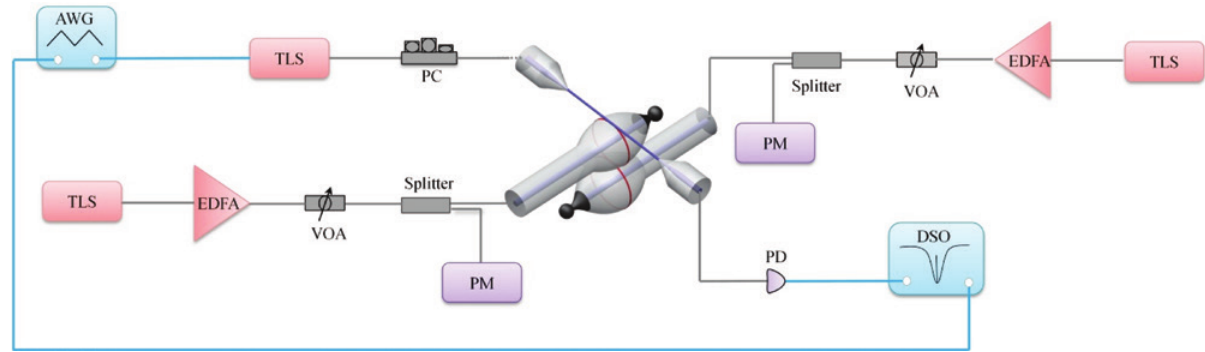
Figure 3: Experimental setup for performance test of all-optical controllable EIT. AWG: arbitrary waveform generator. TLS: tunable laser source, PC: polarization controller, PD: photodetector, DSO: digital storage